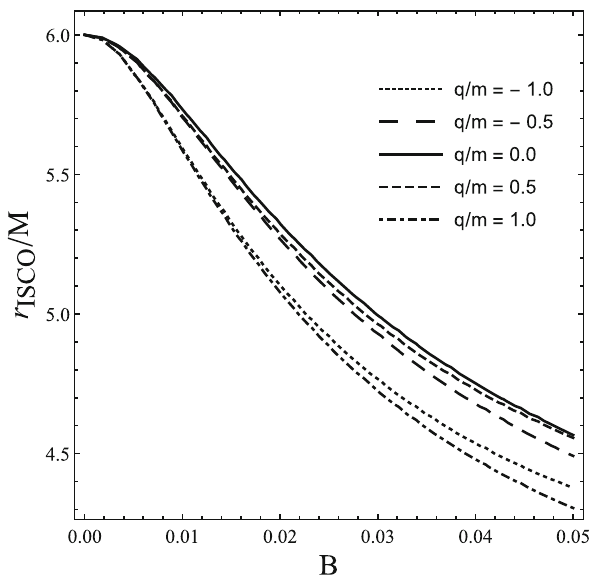
the neutral particle case, i.e. q / m = 0. Right panel: L is plotted for various combinations of charged particle parameter q / m for the fixed B = 0 . 025